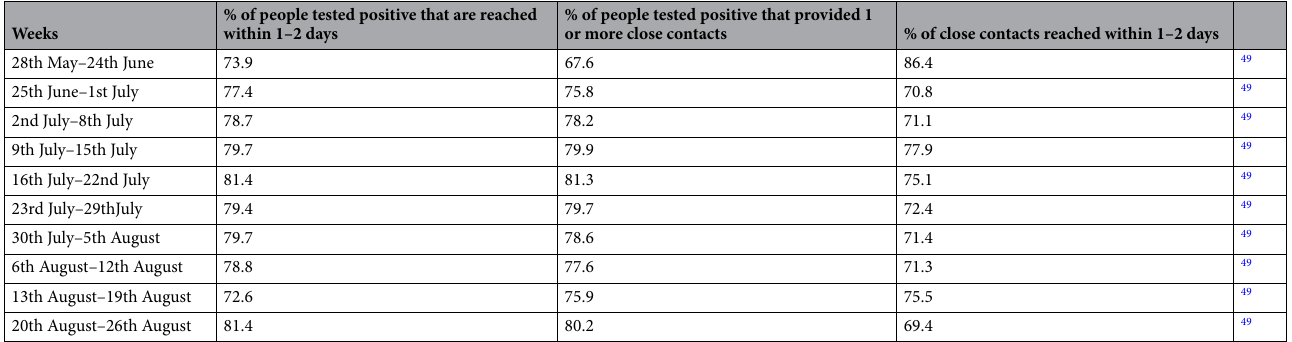
Table 2. Levels of contact tracing during June 2020, July 2020 and August 2020 collated from NHS Test and Trace available at 49 . from weekly report from NHS Test and Trace available from 49